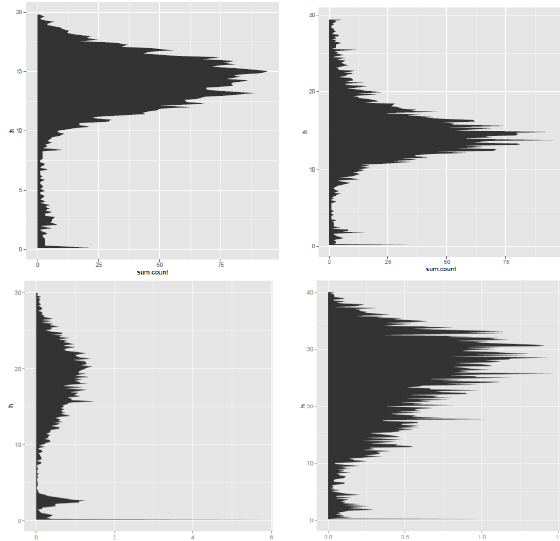
Figure 4. (top-left) level-plot of ground plane raster before filter and (top-right) after filter; (bottom) representation of fitted ground plane and lidar echoes in the sample area, colour scale represents height from ground plane.